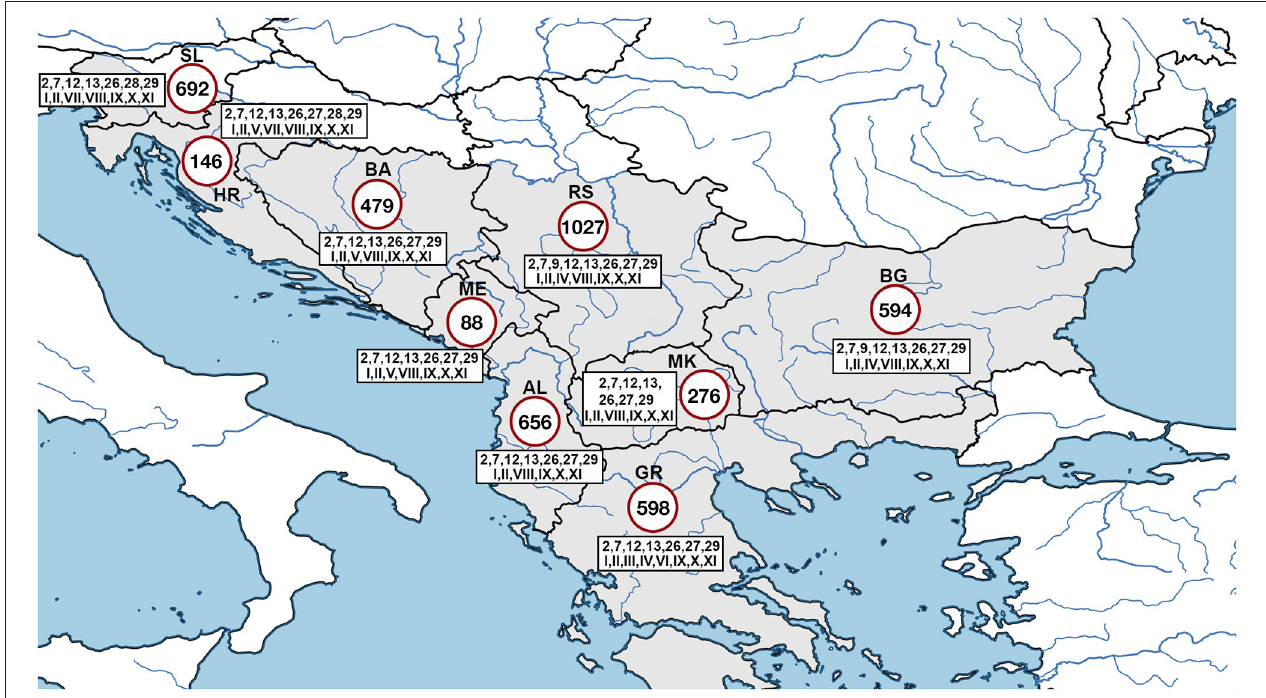
FIGURE 1 | Maximal projected number of SHPPs per country (Schwartz, 2020) on the territory included in this review. Arabic and Roman numbers represent amphibian species listed in Table 1 and reptile species listed in Discussion, respectively, per country (source: Speybroeck et al., 2016). AL, Albania; BA, Bosnia and Herzegovina; BL, Bulgaria; GR, Greece; HR, Croatia; ME, Montenegro; MK, North Macedonia; RS, Serbia; SL, Slovenia.